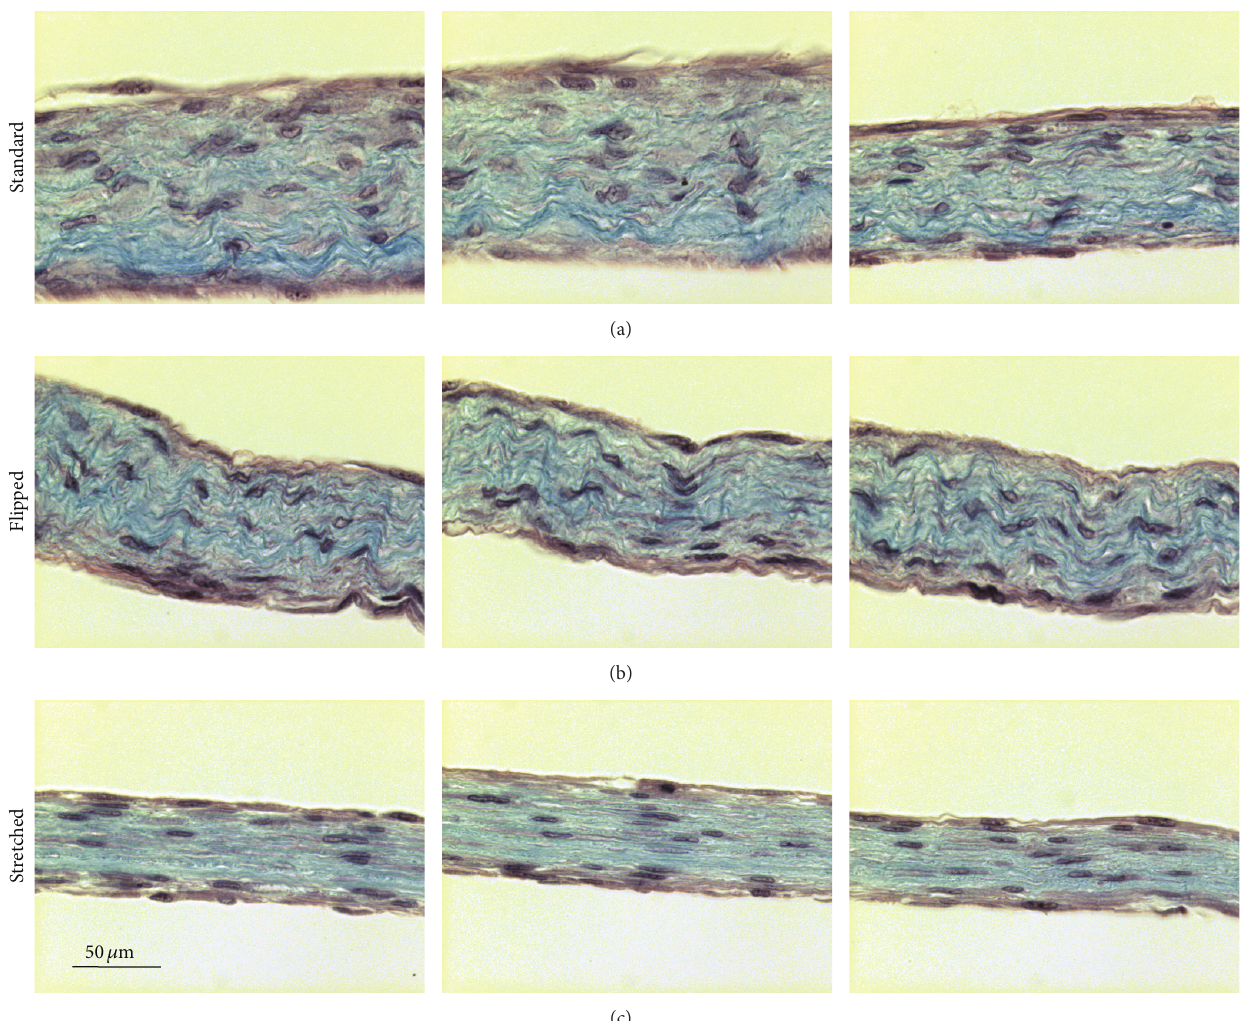
Figure 3: “Stretched” cell culture conditions induced a reorganization of the matrix. Slices of paraffin-embedded tissues produced with standard (a), with “flipped,” or with “stretched” cell culture conditions were subjected to staining using Masson’s trichrome staining. Matrix fibres were stained in blue whereas the cells were stained in purple/pink. The bar scale is 50 𝜇 m for all photographs. Pictures correspond to 3 representative